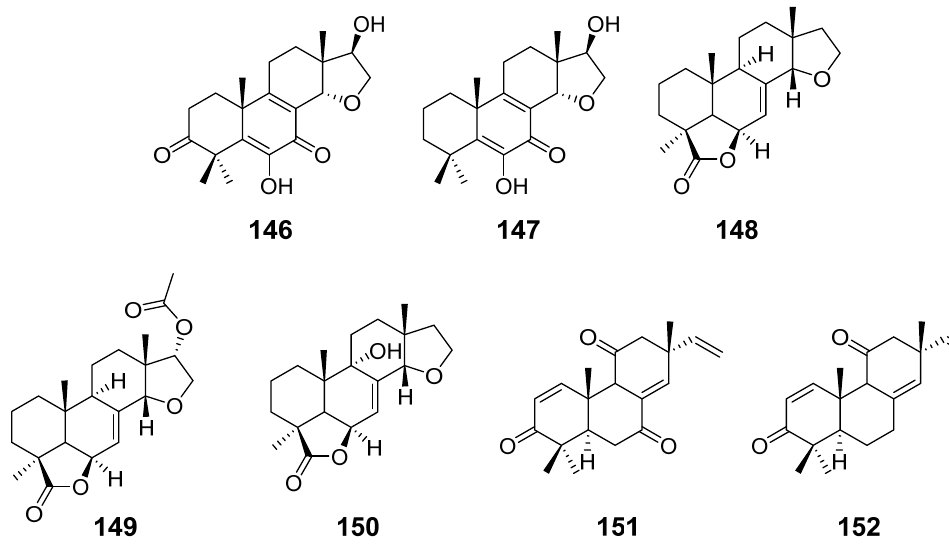
Figure 14. Structures of compounds 146 – 152 .